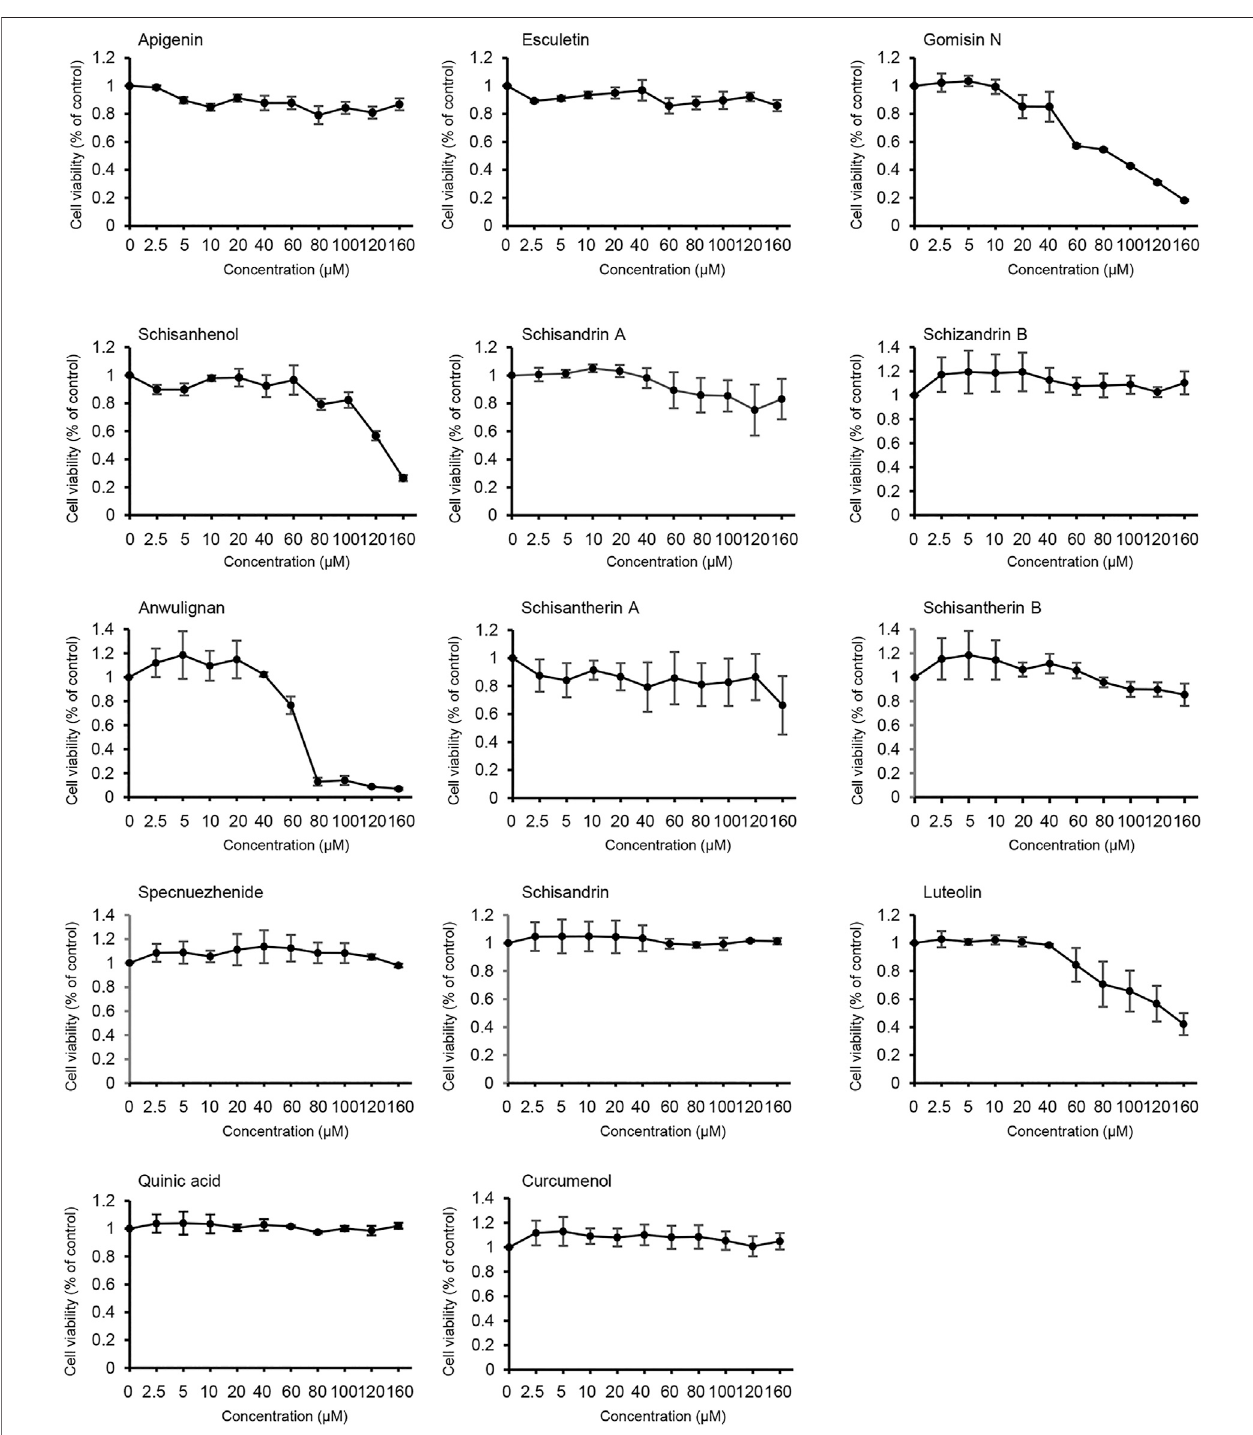
FIGURE 3 | Effects of the active components of LWWL on cell viability. The viability of L02 cells treated with the active components of LWWL for 24 h was determined. Data are presented as mean ± SD using biological samples.